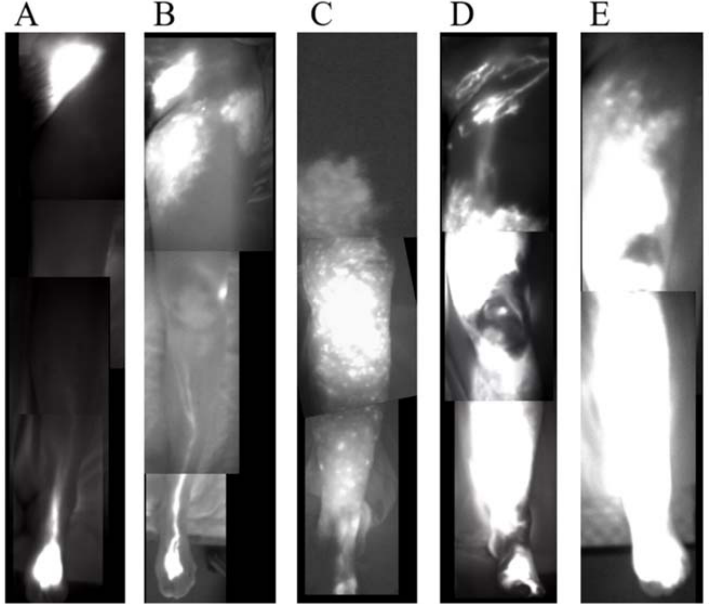
Figure 3. Indocyanine green (ICG) lymphography images of stage I to V. ( A ) Stage 1. Splash pattern around the groin region. ( B ) Stage 2. Stardust pattern extending proximal to the superior border of the patella. ( C ) Stage 3. Stardust pattern extending distal to the superior border of the patella. ( D ) Stage 4. The observed stardust pattern extends to the entire limb. ( E ) Stage 5. The existence of a diffuse pattern with a stardust pattern in the